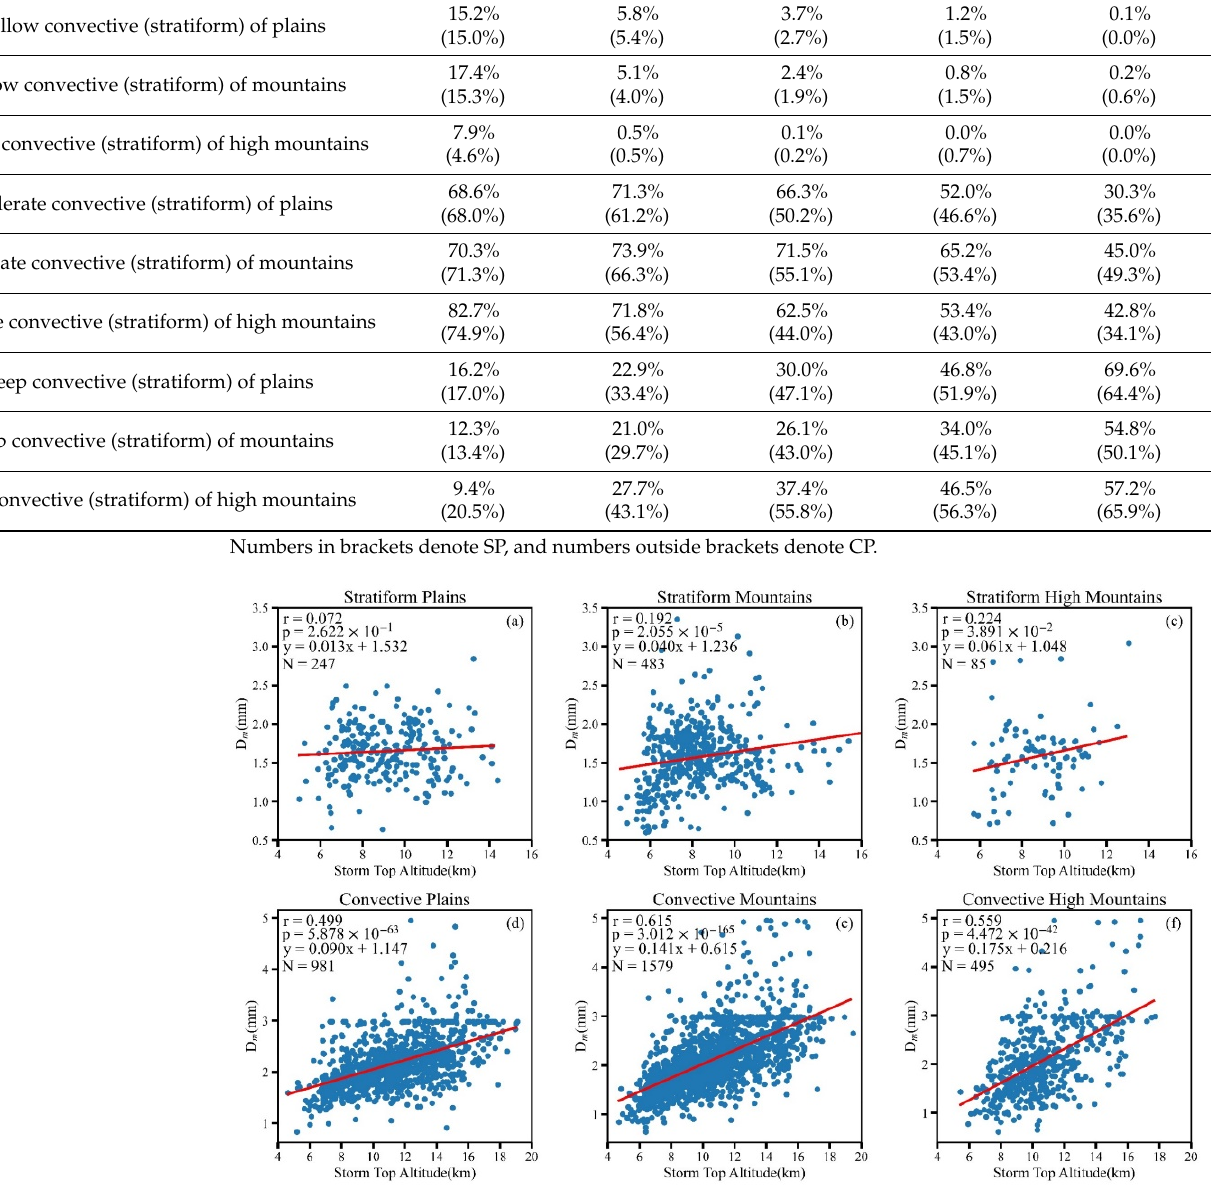
Figure 12. Scatter plots of storm top altitude and D m of two types of heavy precipitation over plains ( a , d ), mountains ( b , e ), and high mountains ( c , f ). r represents Pearson correlation coefficient, p represents significance level, y and red solid lines are the regression equation and N represents sample size.